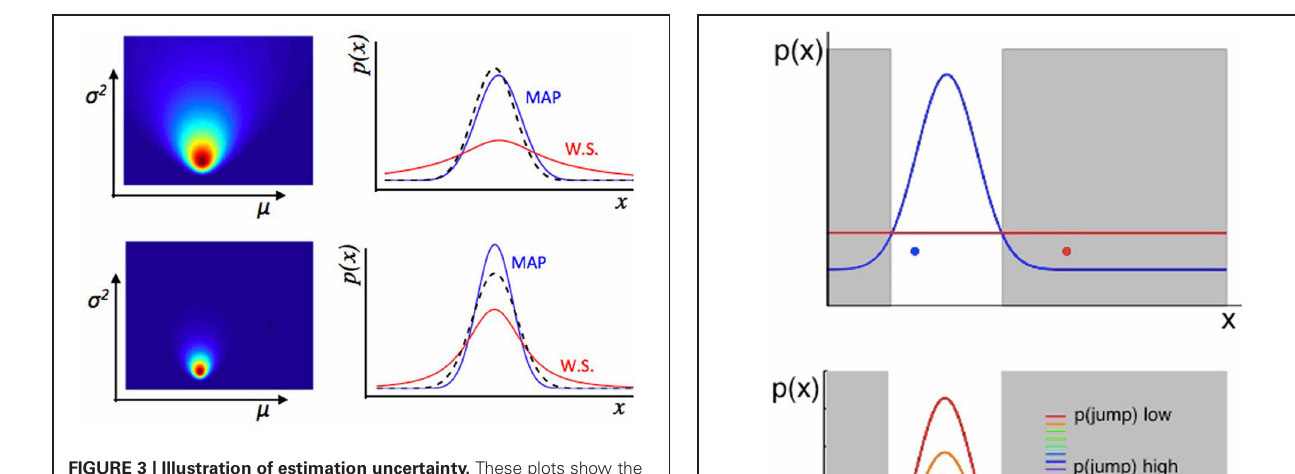
FIGURE 3 | Illustration of estimation uncertainty. These plots show the output of a numerical Bayesian estimation of the parameters of a Gaussian distribution. If x ∼ N ( μ , σ 2 ) , and some values of x are observed, the likelihood of different values for μ , σ 2 can be calculated jointly using Bayes’ rule. The colored plots (left) show the joint likelihood for different pairs of values μ , σ 2 , where each point on the colored image is a possible pair of values μ , σ 2 , and the color represents the likelihood of that pair of values. The line plots ( Right panel ) show the distribution across x implied by different values of μ , σ 2 . The dashed black line is the true distribution from which data were drawn. The blue line is the maximum a-posteriori distribution—a Gaussian distribution with values of μ , σ 2 taken from the peak of the joint distribution over μ , σ 2 shown on the left. The red line represents a weighted sum (W.S.) of the Gaussian distributions represented by all possible values of μ , σ 2 , weighted by their joint likelihood as shown in the figure to the left. The top represents an estimate of the environment based on fewer data points than the bottom row. With relatively few data points, there is a lot of uncertainty about the values of μ , σ 2 , i.e., estimation uncertainty—illustrated by the broader distribution of likelihood over different possible values of μ , σ 2 ( Left panel ) in the top than bottom row. Whilst the maximum a-posteriori distribution is a good fit to the “true” distribution from which data were drawn in both cases, if we look at the weighted sum of all distributions, there is a lot more uncertainty for the top row case, based on fewer data points. Hence if the observer uses a weighted sum of all possible values of μ , σ 2 of the environment to calculate a probability distribution over x , the variance of that distribution depends on the level of estimation